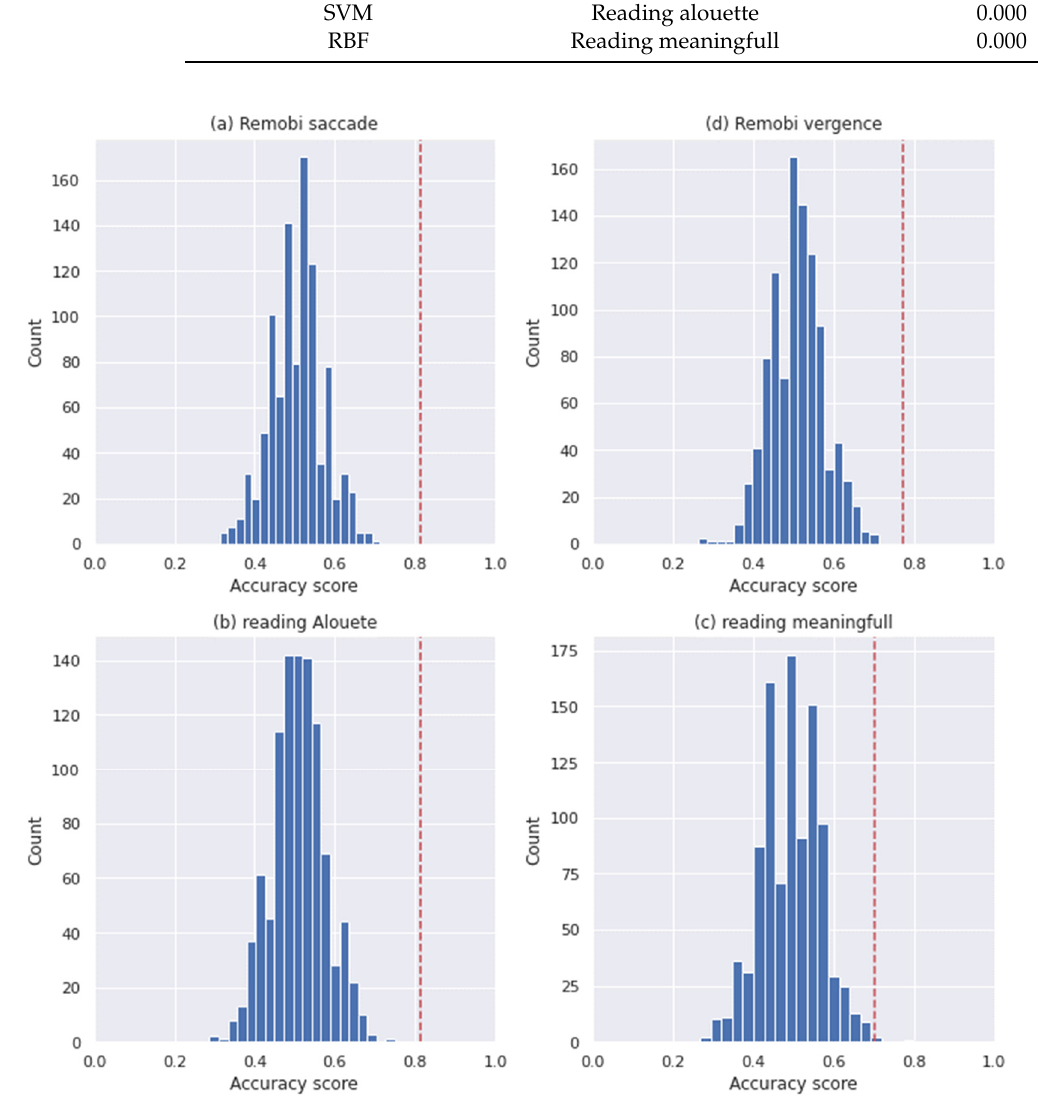
Figure 2. Logistic regression test permutation histograms for Analysis 1, the red line indicated the reported score. ( a ) the histogram of the Remobi saccade dataset. ( b ) the histogram of the Remobi vergence dataset. ( c ) the histogram of the reading Alouette, ( d ) the histogram of the reading meaningful.